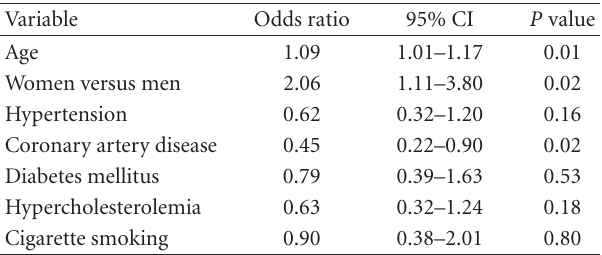
Table 2: Logistic regression analysis for mitral annular